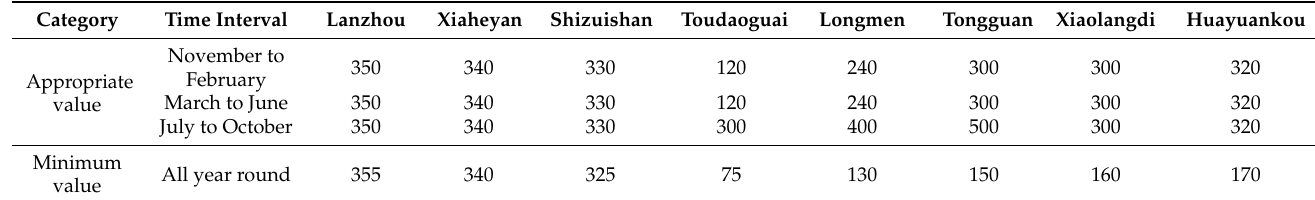
Table 3. Self-purification water requirements on the Yellow River typical cross-section at the present stage unit: m 3 · s − 1 . Category Time